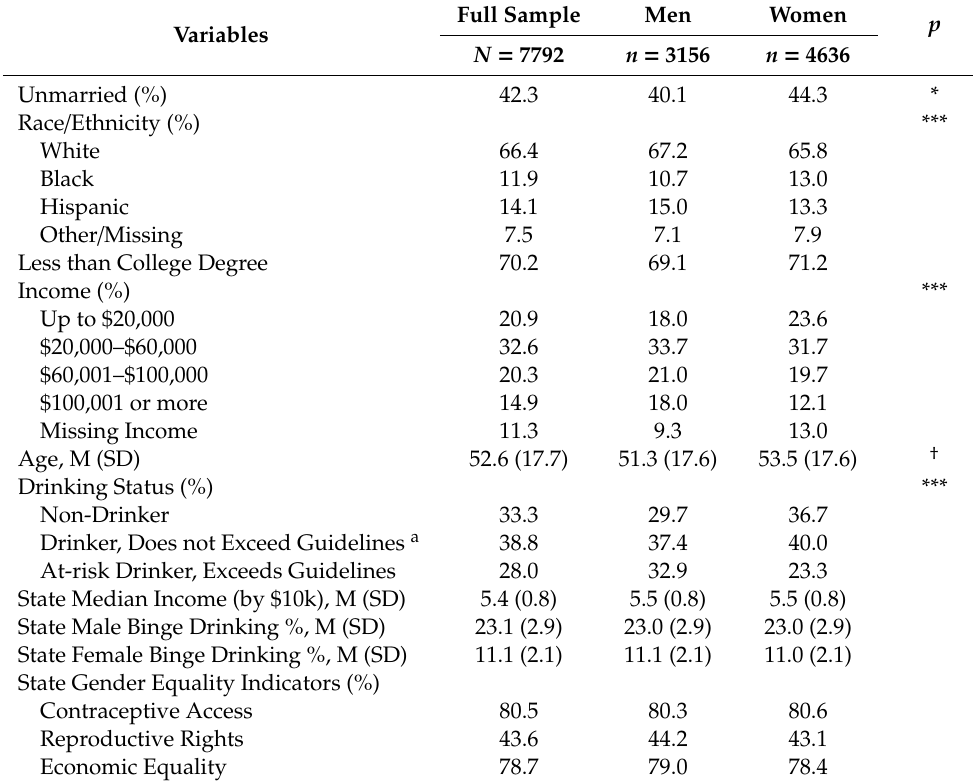
Table 1. Sample descriptives and weighted bivariate comparisons by gender ( N =